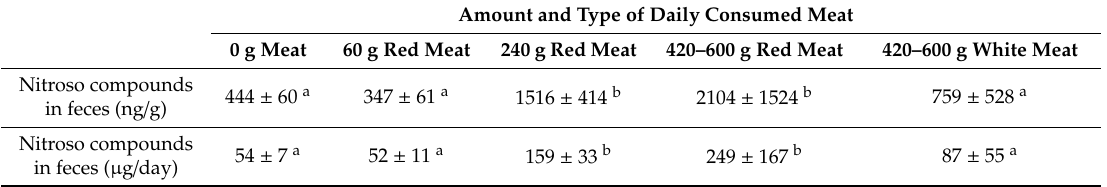
Table 1. E ff ect of meat consumption on the concentration of nitroso compounds in feces (modified from [9,10]). Amount and Type of Daily Consumed Meat 0 g Meat 60 g Red Meat 240 g Red Meat 420–600 g Red Meat 420–600 g White Meat Nitroso compounds in feces (ng /